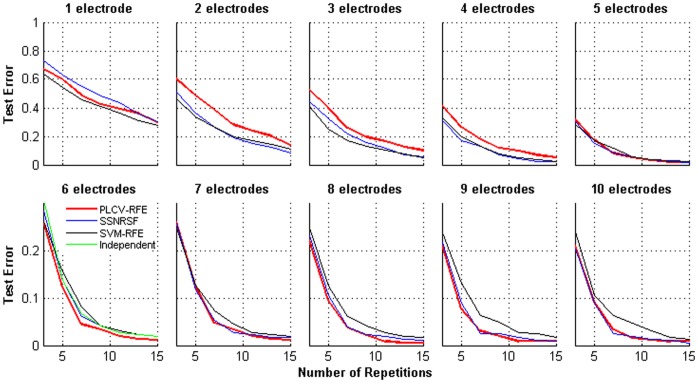
The comparison of character recognition errors.CREs of 1 to 10-channel subsets are shown against the number of repetitions with different methods.